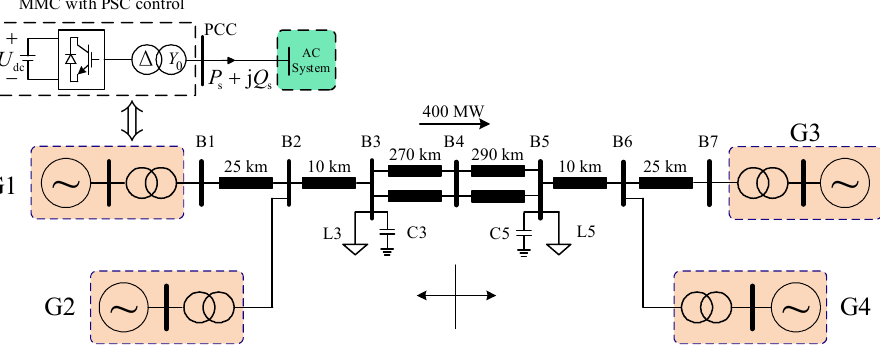
Figure 10. The 2-area 4-machine power system.